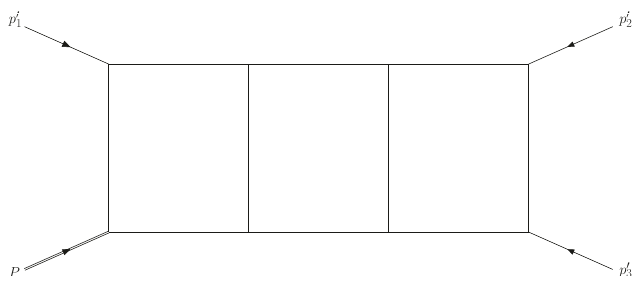
Figure 2 . The ladderbox (F1) family using the notation followed in [33]. The double line represents the massive particle and all external momenta are taken to be